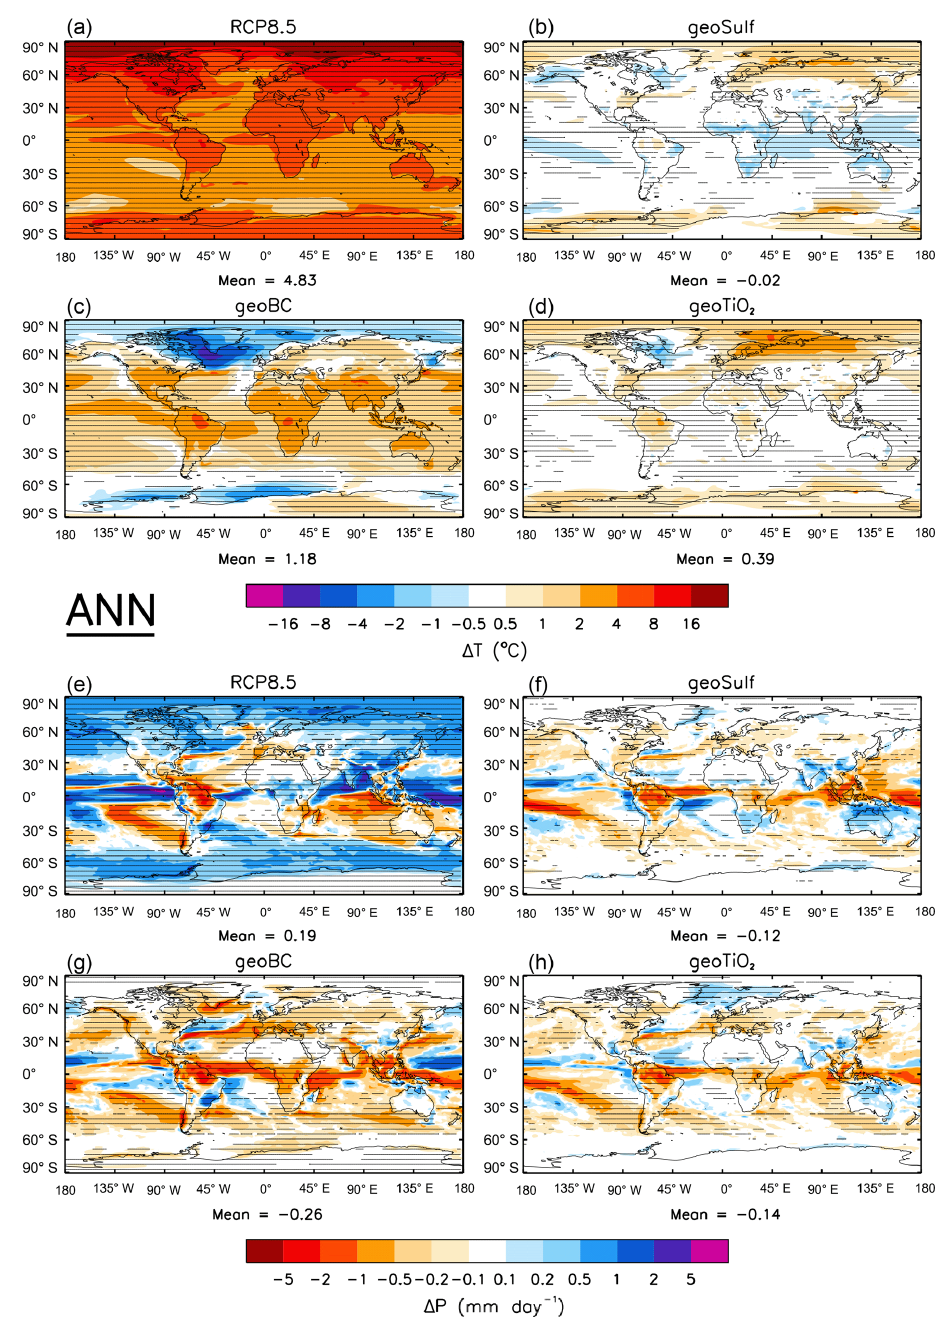
Figure 6. Annual-mean near-surface air temperature (top) and precipitation rate (bottom) anomalies with respect to HIST. Stippling indicates where changes are significant at the 5% level using a two-tailed Student’s t